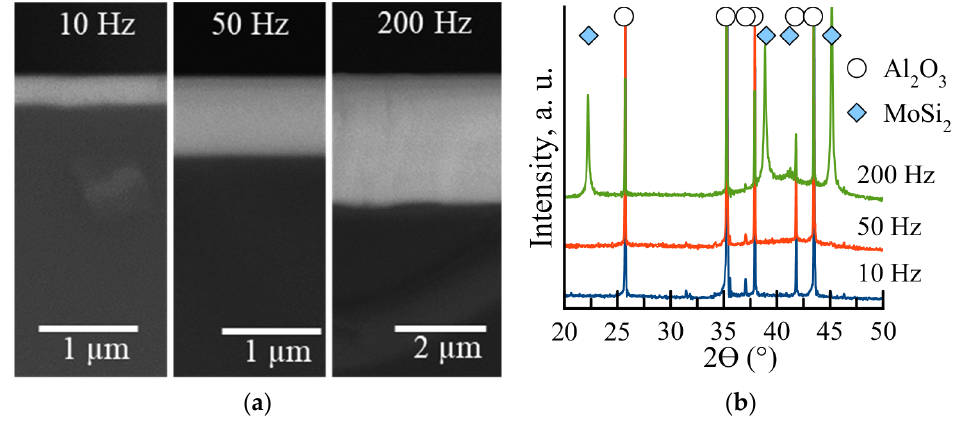
Figure 1. Cross ‐ section SEM images of coatings ( a ) and the respective XRD patterns ( b ). Figure 1. Cross-section SEM images of coatings ( a ) and the respective XRD patterns ( b ). The minimal thickness (0.3 µ m) and growth rate (7.5 nm/min) were observed